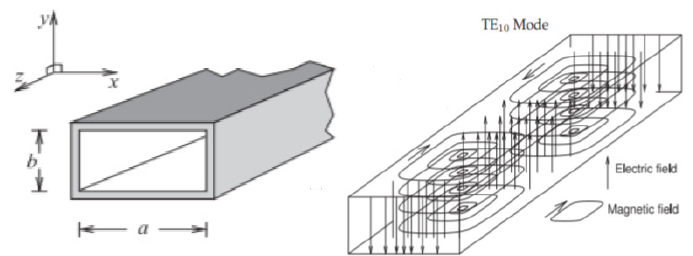
Figure 1. Three-dimensional view of a waveguide (on the left ). Electromagnetic field distribution for the mode TE 01 (on the right